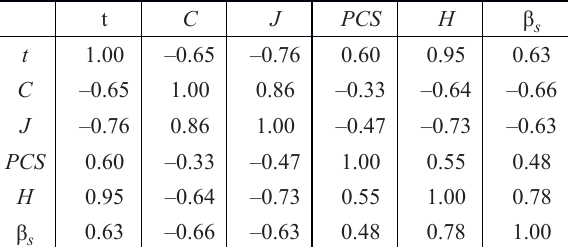
Table 3. Pair correlation matrix of carbonic residual specimen group of treated wood characteristics